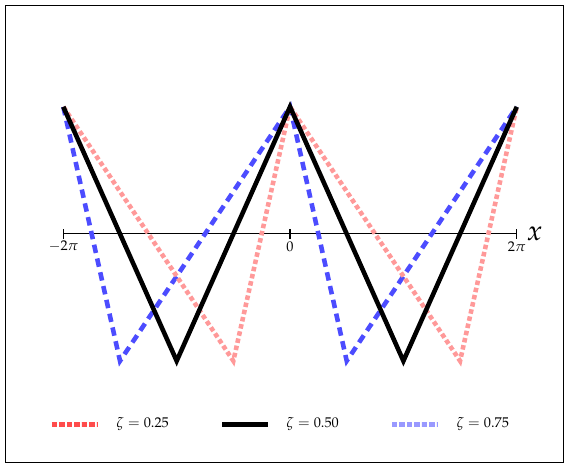
Figure 5. Asymmetric model g asy ( x , ζ ) , 0.25, 0.5, 0.75 . This model allows the maximization of ∈ { } for ζ 0.25, 0.5, 0.75 . This model ∈ { } allows the maximization of the sum of the margins.